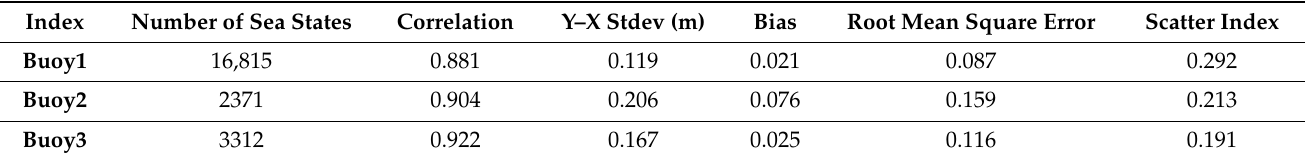
Figure 4. Time-series comparison of hindcast Hs versus buoy-observed Hs. The red circles indicate the procedure of typhoon Kalmeage in 2014. Table 1. Statistical comparisons between wave WW3 hindcast data and buoy